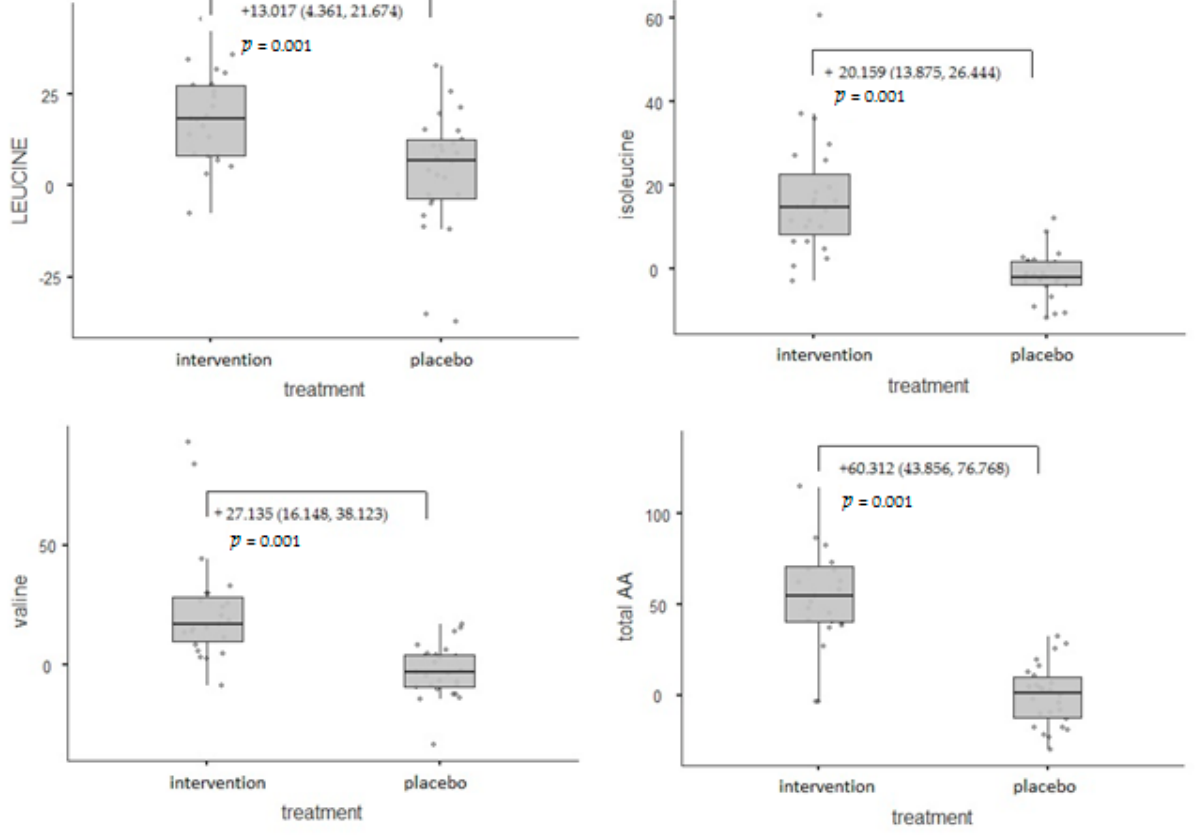
Figure 4. Between-group effects on the amino acids profile.